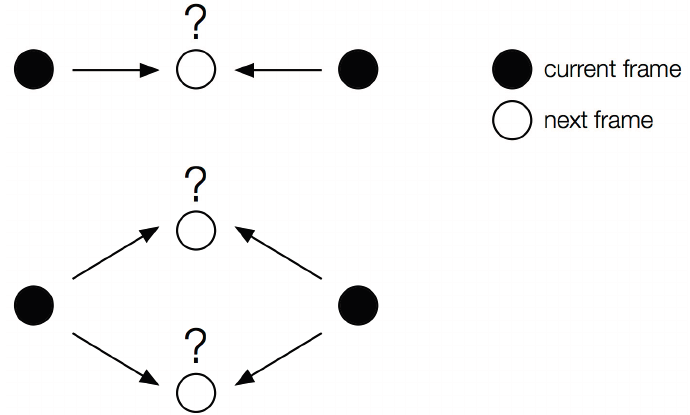
Figure 7. Single-molecule tracking requires low fluorophore densities. If too many localizations occur in proximity to one another, the tracking algorithm may not be able to correctly assign molecular